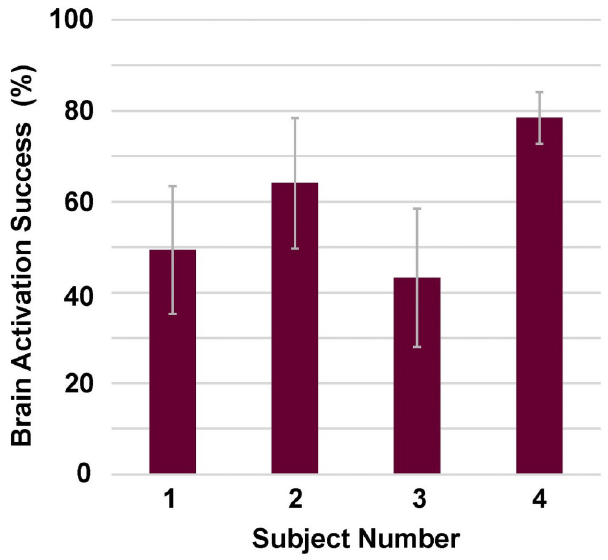
Fig 7. Brain activation mean success rate during rt-fNIRS neural feedback training, for each of four subjects. For each stroke survivor, mean (rectangle height) success rate for the 10 rt-fNIRS neural training sessions is shown with standard deviation (gray standard deviation